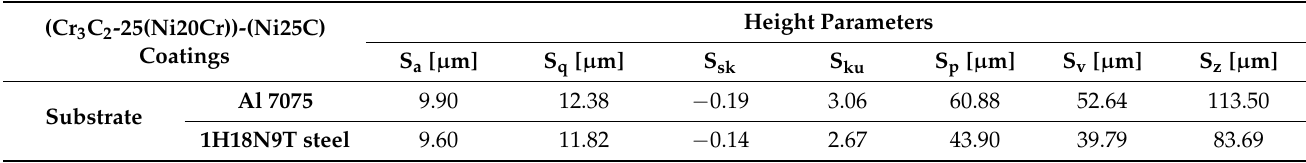
Table 3. The surface topography parameters of coatings according to ISO 25178